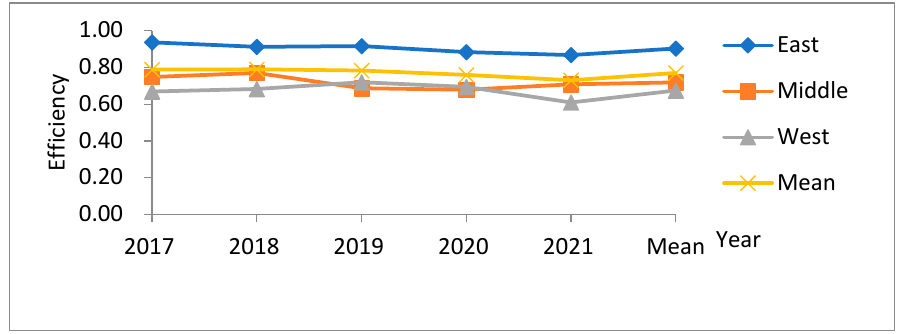
Figure 2. Trend of overall Green Buildings’ implementation efficiency during 2017–2021.